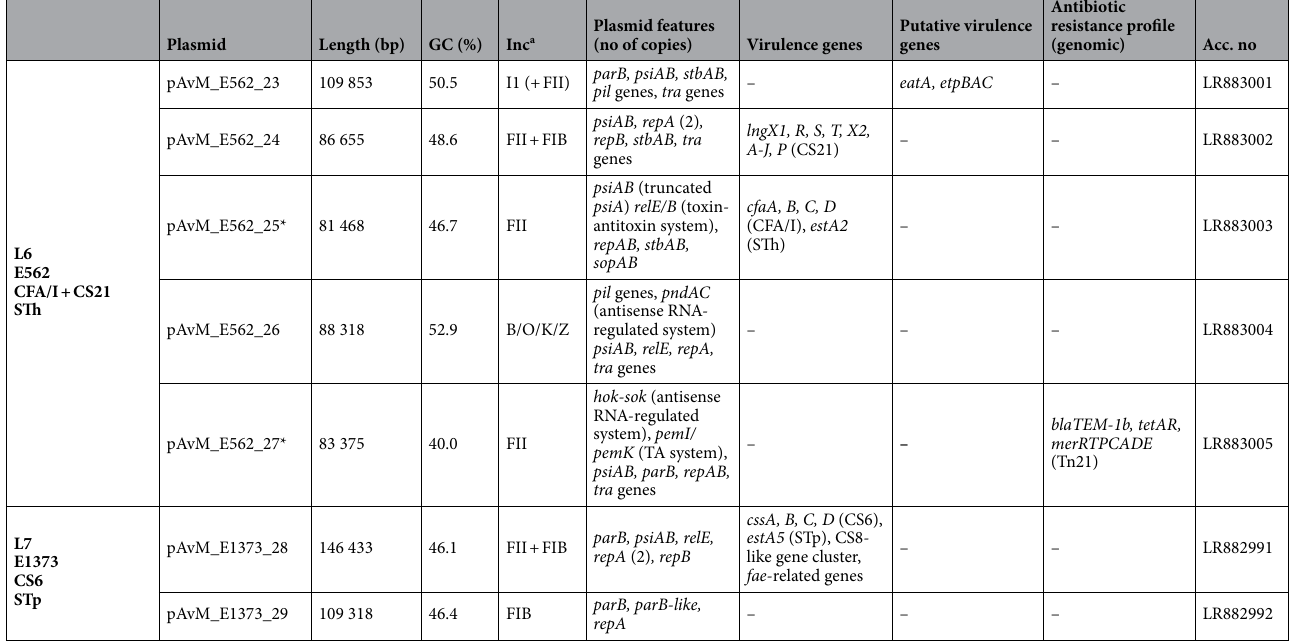
Table 2. Description of the plasmids present in the 8 ETEC reference strains. a Incompatibility groups were determined by PlasmidFinder 34 and pMLST 34 for subtyping. *Plasmids not